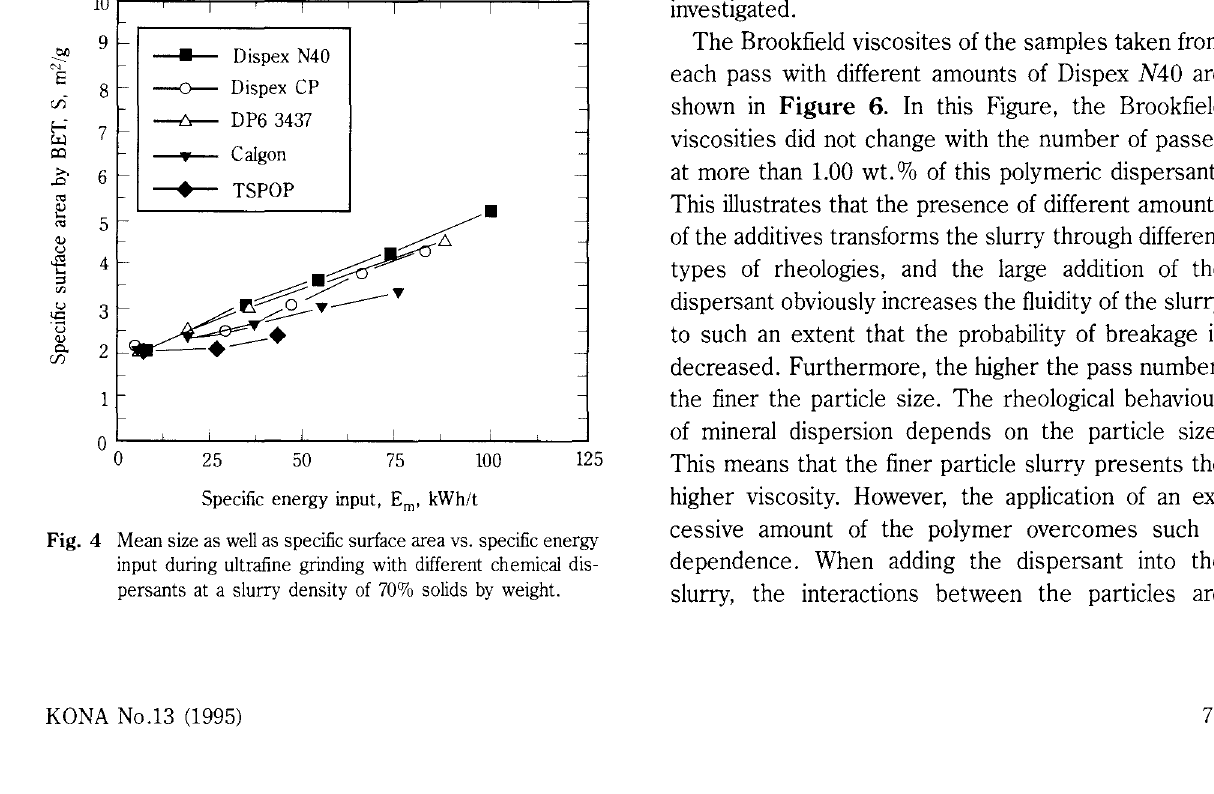
Fig. 4 Mean size as well as specific surface area vs. specific energy input during ultrafine grinding with different chemical dis persants at a slurry density of 70o/o solids by